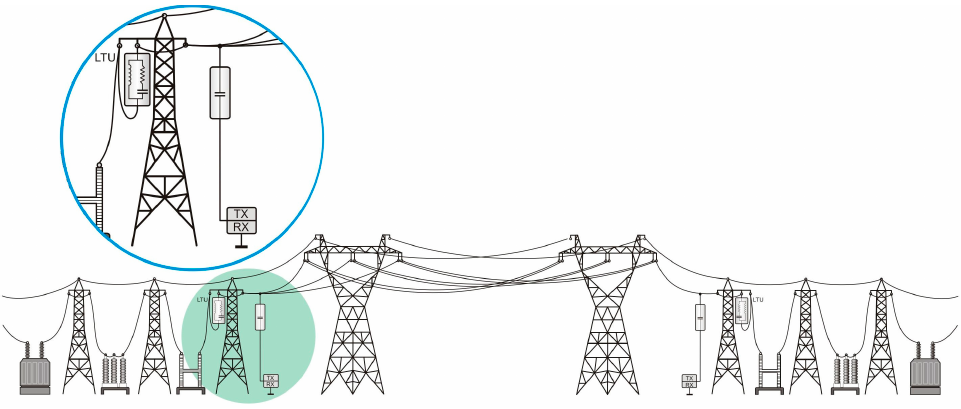
Figure 1. High voltage power line utilized for communications.